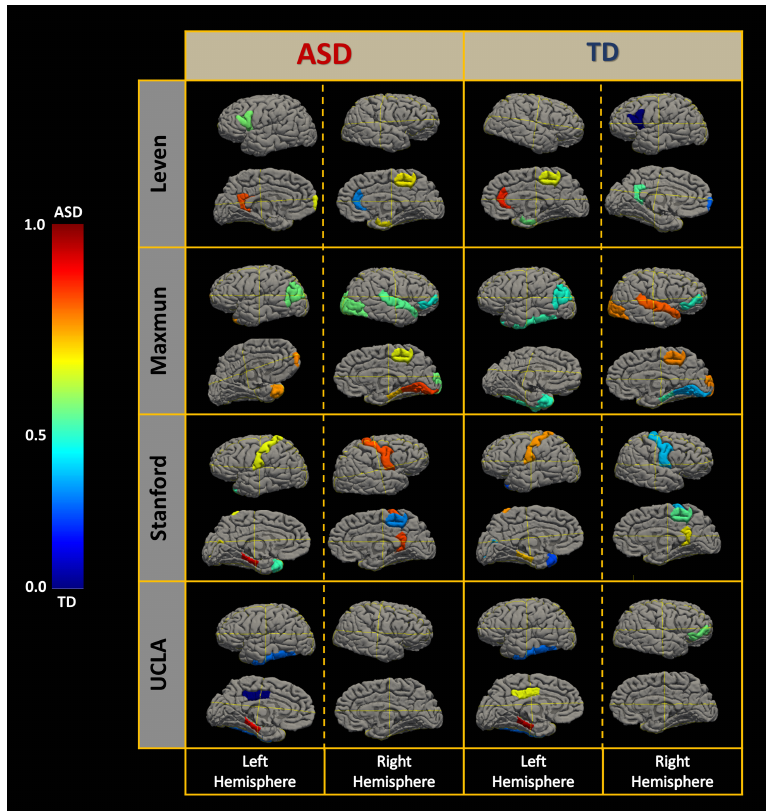
Figure 6. Personalized diagnosis.